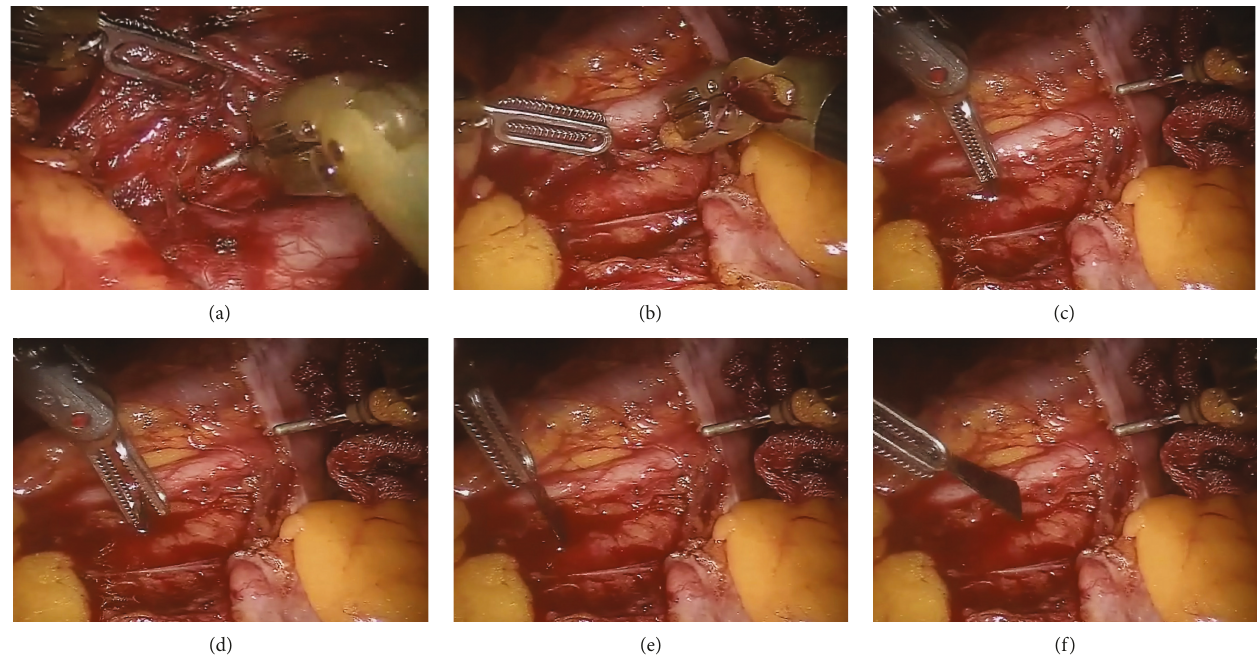
Figure 2: Intraoperative pictures of the robot-assisted removal of the broken